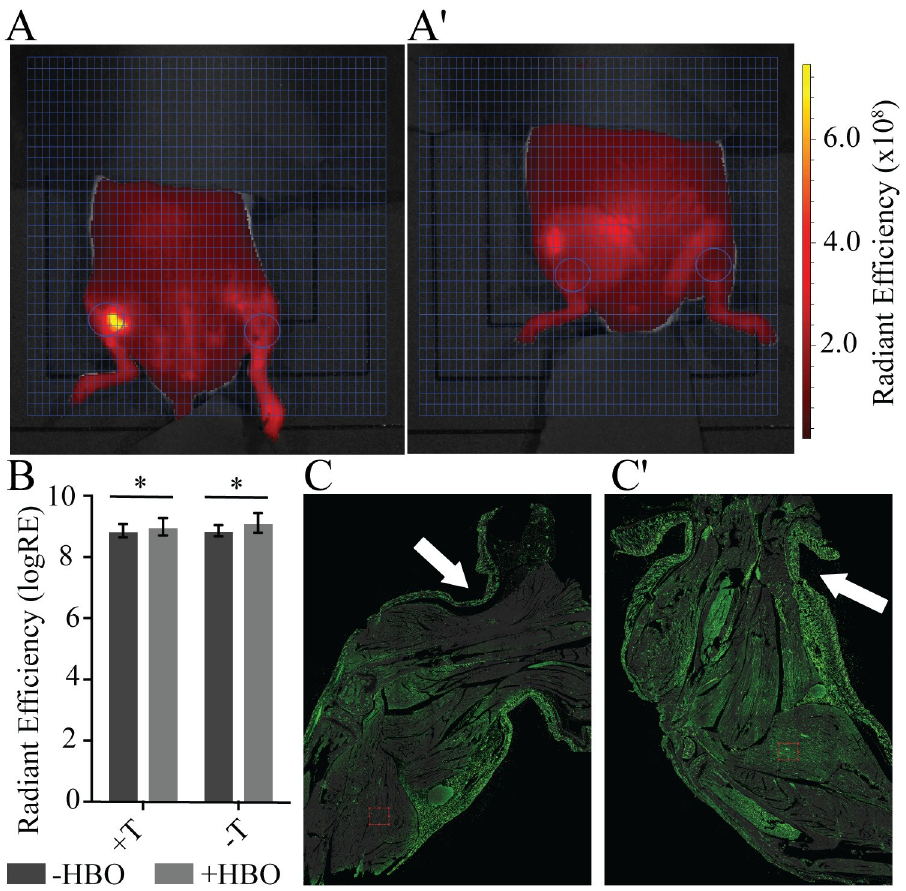
Fig 5. A single application of hyperbaric oxygen (HBO) decreases intracellular hypoxia. Region of interest (ROI— circles) targets the tissue distal to the tourniquet in tourniqueted (L) and untourniqueted (R) limbs for A) +HBO and A’) -HBO. Ventral view. Fluorescent signal indicates Neutrophil Elastase FAST detection (red) in units of radiant efficiency (see scale bar). Representative images shown, N = 8 (-HBO) and 10 (+HBO). B) Treatment with HBO increases neutrophil elastase activity in both the tourniqueted and untourniqueted legs, as compared to the -HBO control group. N = 8 (-HBO) and 10 (+HBO). Error bars represent SD . C) Intracellular hypoxia (Hypoxyprobe— green) is reduced when HBO is applied while the tourniquet is in place, as compared to C’) an untreated leg. Hypoxyprobe signal marks cells with < 1.3% oxygen. Arrows indicate tourniquet (T) location on